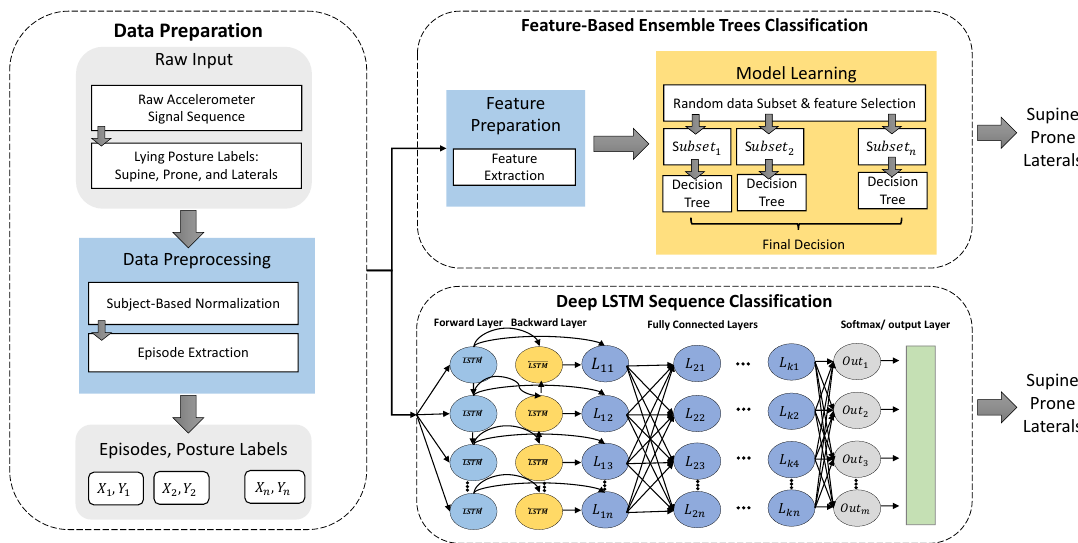
Figure 1. The process of training feature-based ensemble trees and Deep LSTM classifiers. Symbol L kn represents the fully connected unit n at layer k . Symbol k refers to the number of the fully connected layers and symbol m shows the number of the output